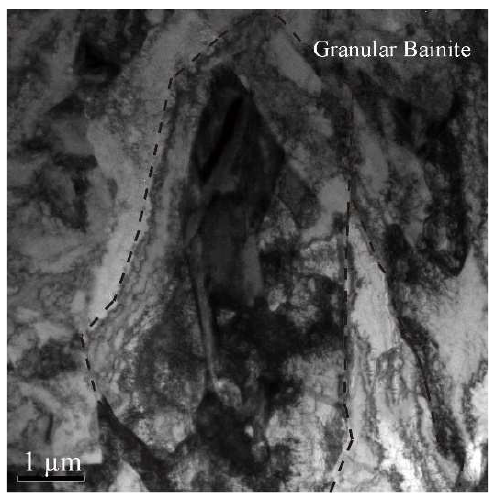
Figure 10. Granular bainite with high dislocation density.